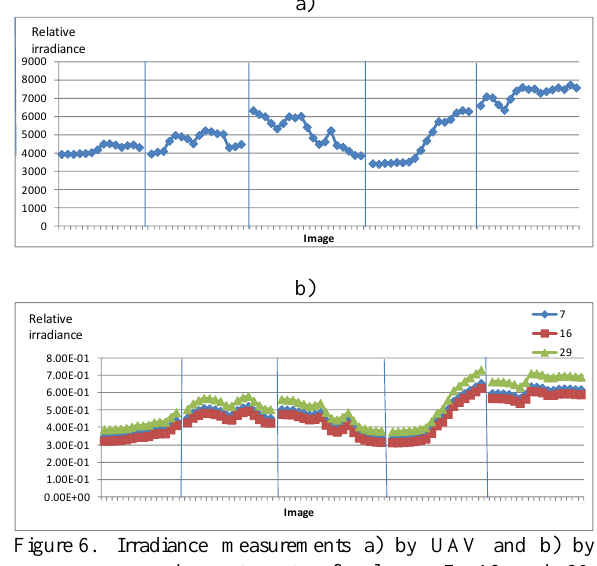
Figure 6. Irradiance measurements a) by UAV and b) by ground spectrometer for layers 7, 16 and 29. Vertical lines separate the different image